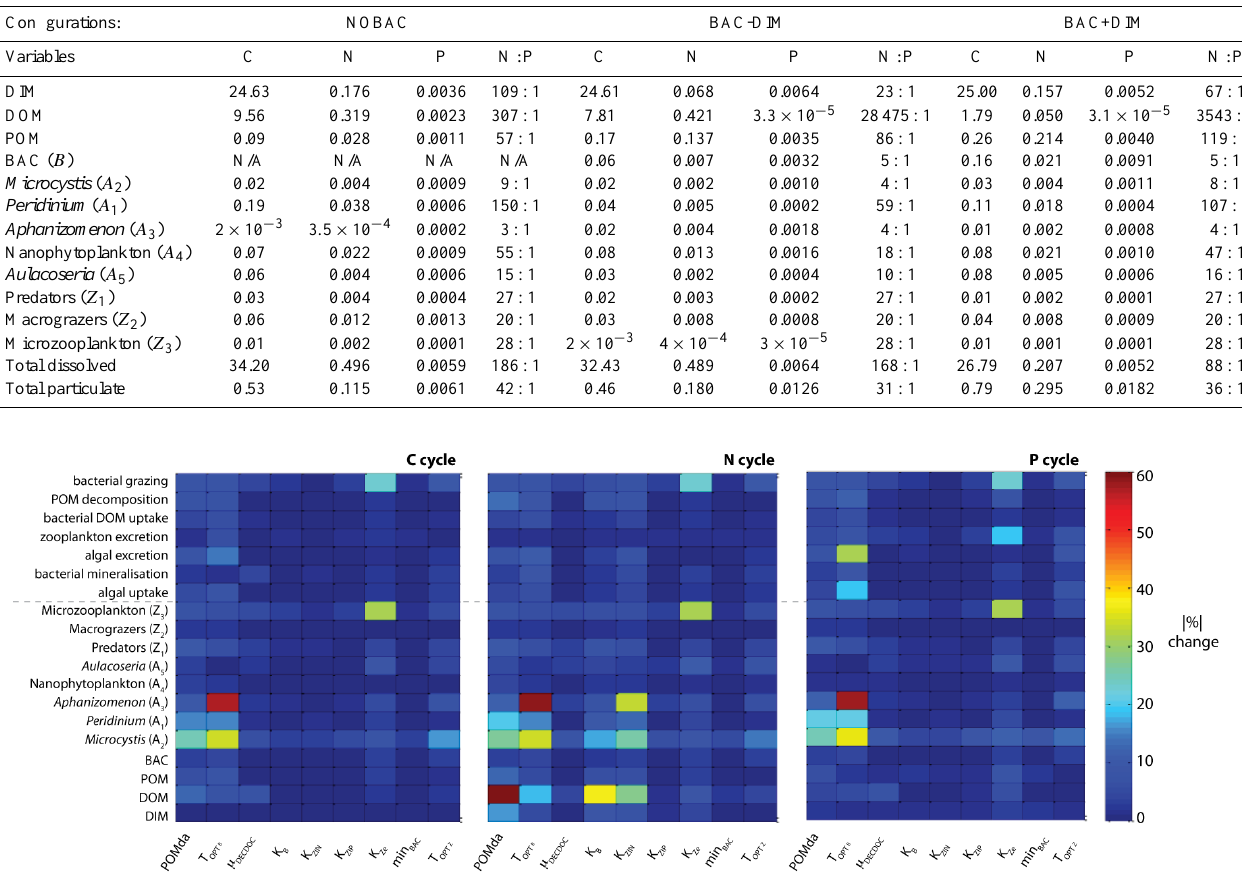
Figure 3. Local sensitivity analysis of simulated state variables and process rates for the C, N and P cycles presented as the lake average absolute change after a ± 20% parameter